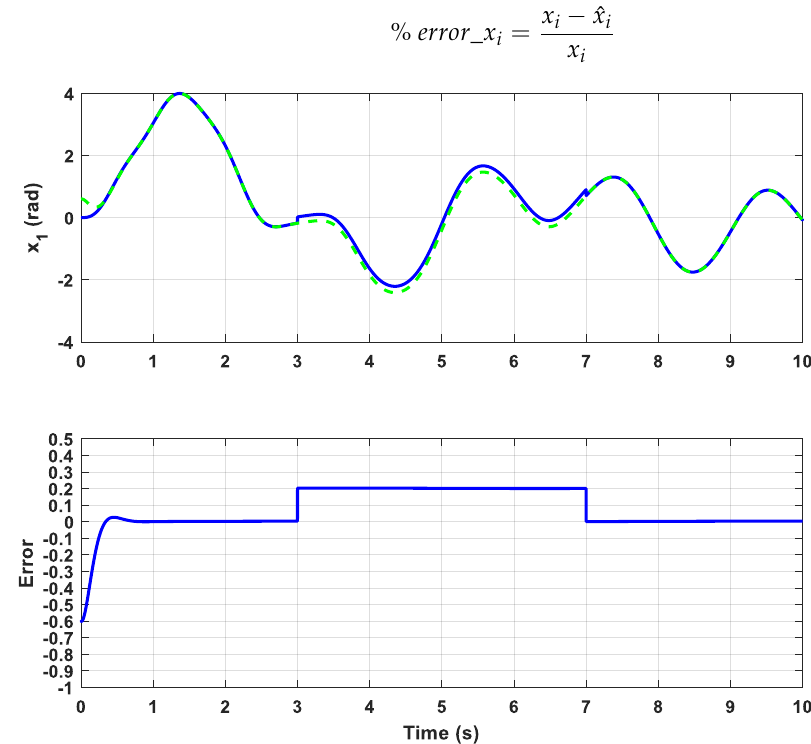
Figure 5. Estimation and error of motor angle.